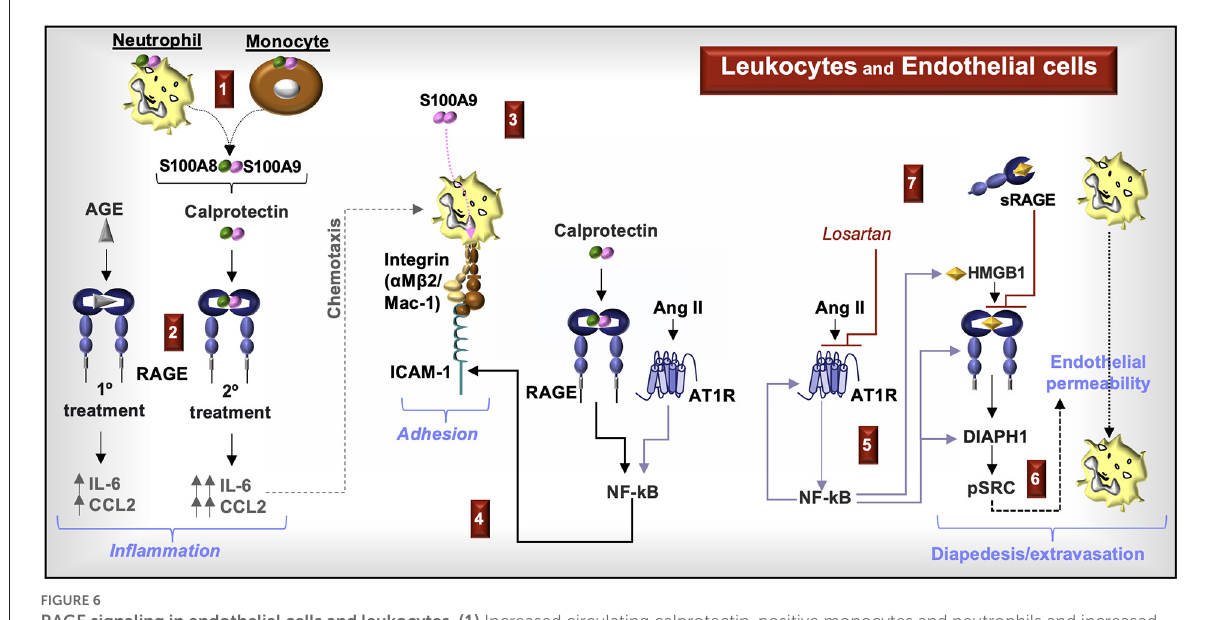
FIGURE6 RAGE signaling in endothelial cells and leukocytes . (1) Increased circulating calprotectin-positive monocytes and neutrophils and increased serum calprotectin levels are characteristic of CKD. (2) Priming endothelial cells with AGE prior to stimulation with calprotectin increases the production of chemokines CCL2 and IL-6. (3) S100A9 induces leukocyte cell surface expression of Mac-1. (4) Calprotectin activation of RAGE and Ang II activation of the Ang II type I receptor (AT1R) induces NF-kB and increased cell surface expression of intracellular adhesion molecule (ICAM)-1, which enhances leukocyte adhesion to Mac-1. (5) Ang II-induced NF-kB promotes the expression and production of AT1R, RAGE, DIAPH1, and HMGB1. (6) Ang II induces endothelial permeability by inducing the phosphorylation of Src in a RAGE- and DIAPH1-dependent manner. (7) Blocking AT1R with an AT1R blocker, losartan, or RAGE with soluble RAGE (sRAGE) reduces endothelial permeability, which facilitates leukocyte diapedesis and